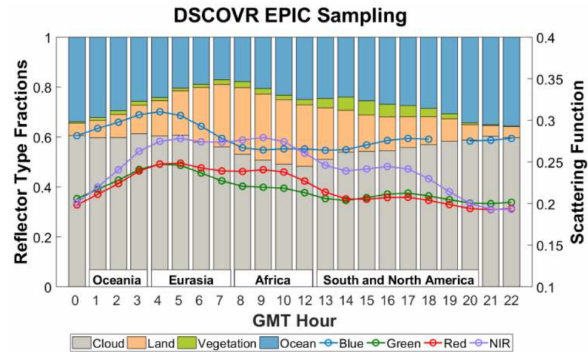
Figure 6. Diurnal variations of the fractional coverage of different Earth components (left vertical axis) and EPIC scattering function at the blue (443 nm), green (551 nm), red (680 nm) and NIR (780 nm) wavelengths (right vertical axis). Continents present in the image are shown on the horizontal